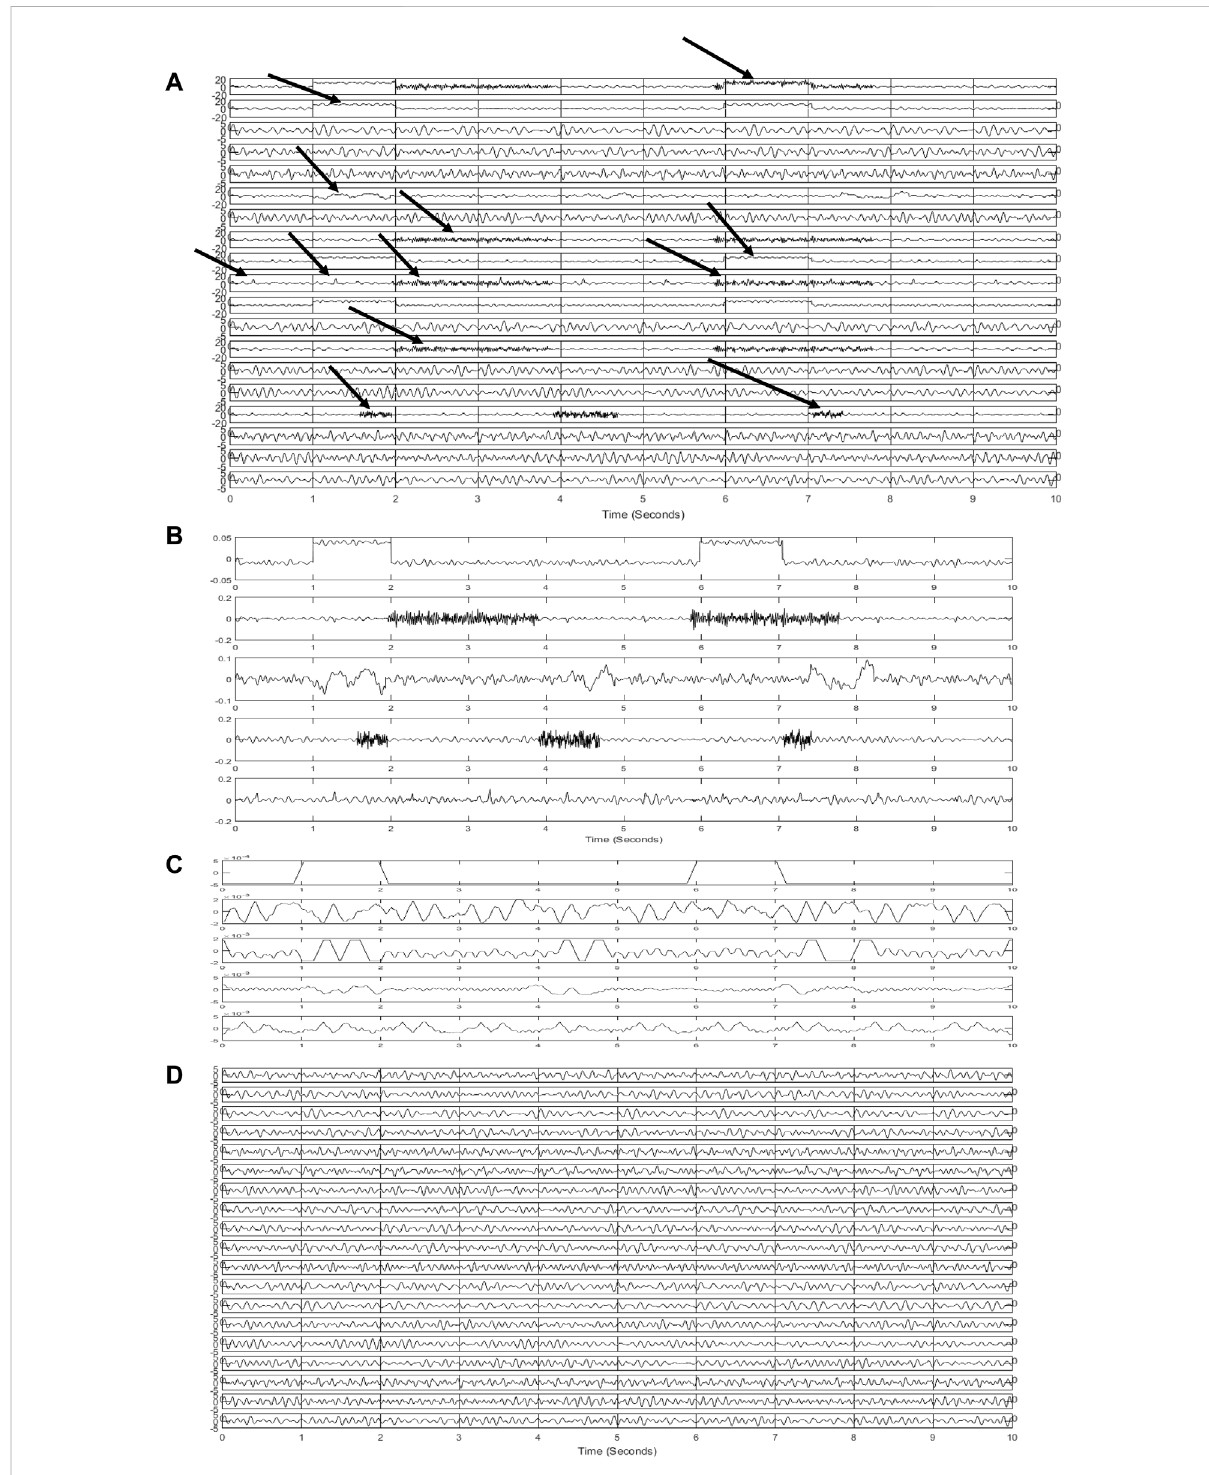
FIGURE 4 Results of the proposed method for simulated signals (A) simulated and contaminated EEG (B) detected artifactual components (C) denoised components using SWT (D) reconstructed